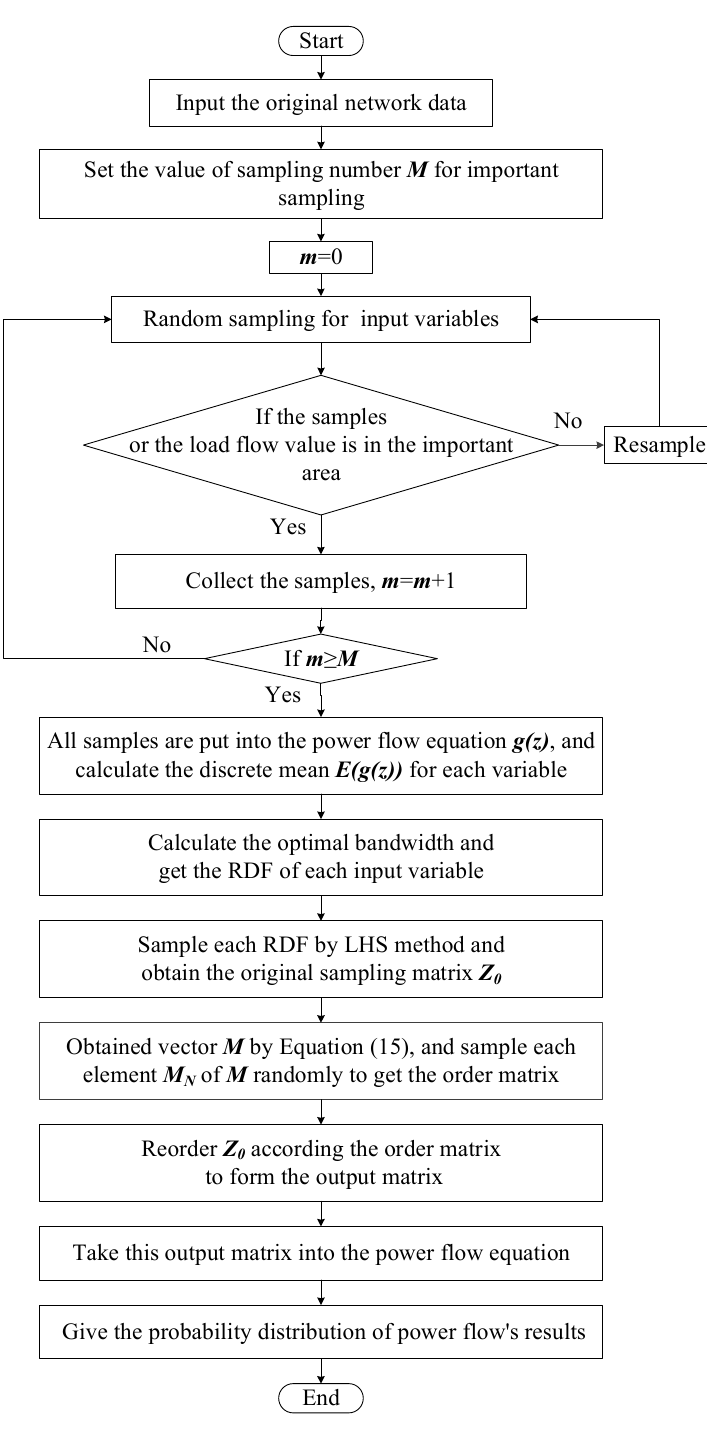
Figure 3. Flowchart of the Latin hypercube-important sampling method (LHISM) algorithm.